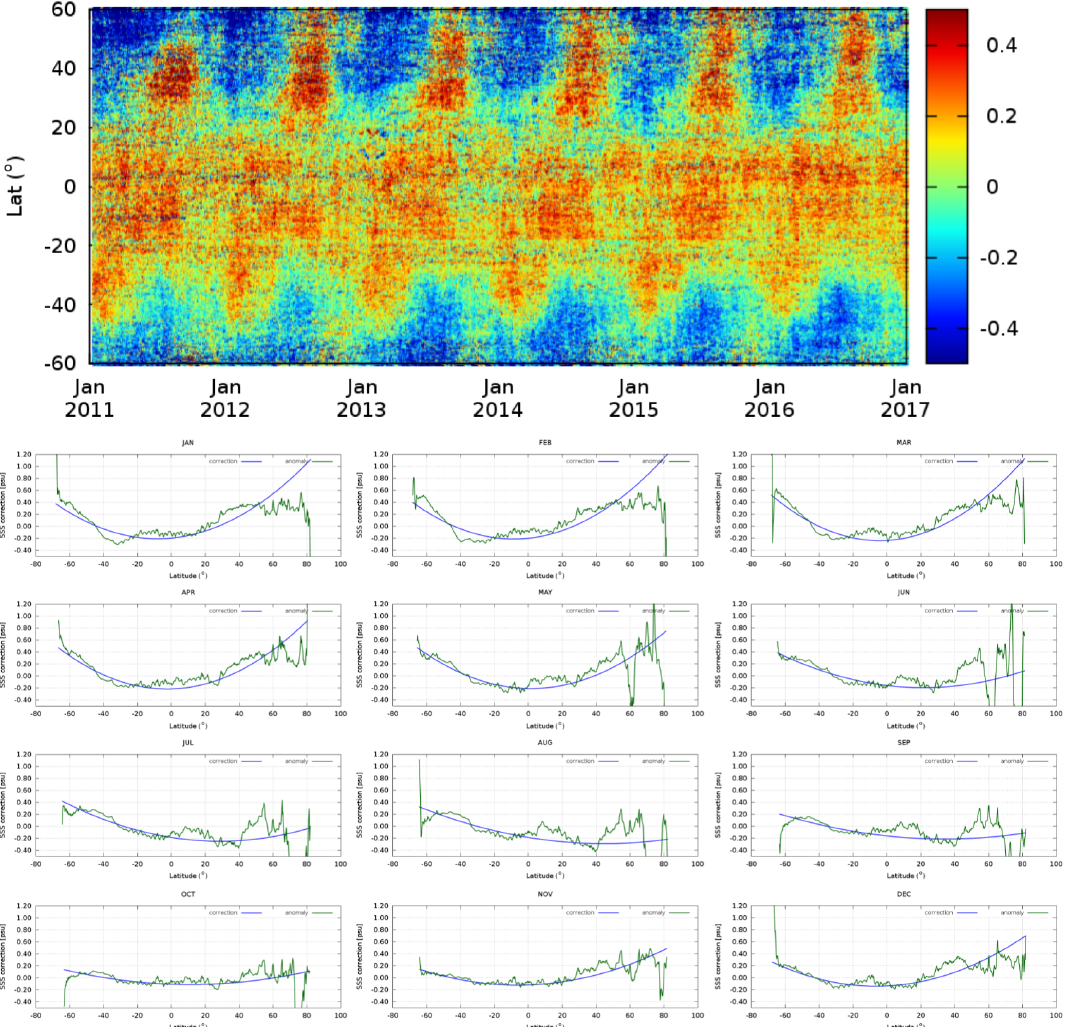
Figure 2. (a) Latitudinal and seasonal bias affecting the BEC SMOS SSS L3 maps after applying the systematic bias correction proposed in Sect. 2.2.1 and the temporal correction proposed in Sect. 2.2.4. The plot represents a Hovmöller diagram of the temporal evolution of the differences between the BEC SMOS SSS and the Argo SSS in latitudinal bins of 0 . 25 ◦ . (b) In the last four rows the monthly interpolating polynomial (in blue) is presented as well as the mean difference between the monthly SMOS climatology and the monthly WOA13 (in green) (i.e., (cid:49)s 1 ( m,ϕ,λ ); see text in Sect.